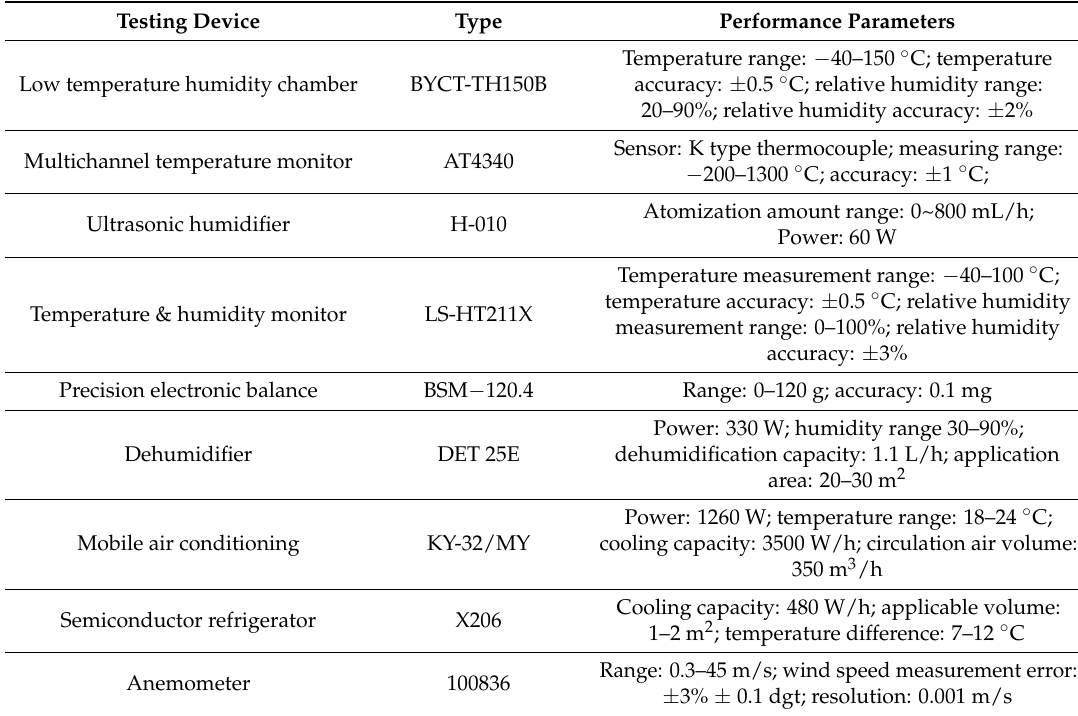
Figure 7. Image of the testing rig. Table 1. Performance parameters of the testing devices.